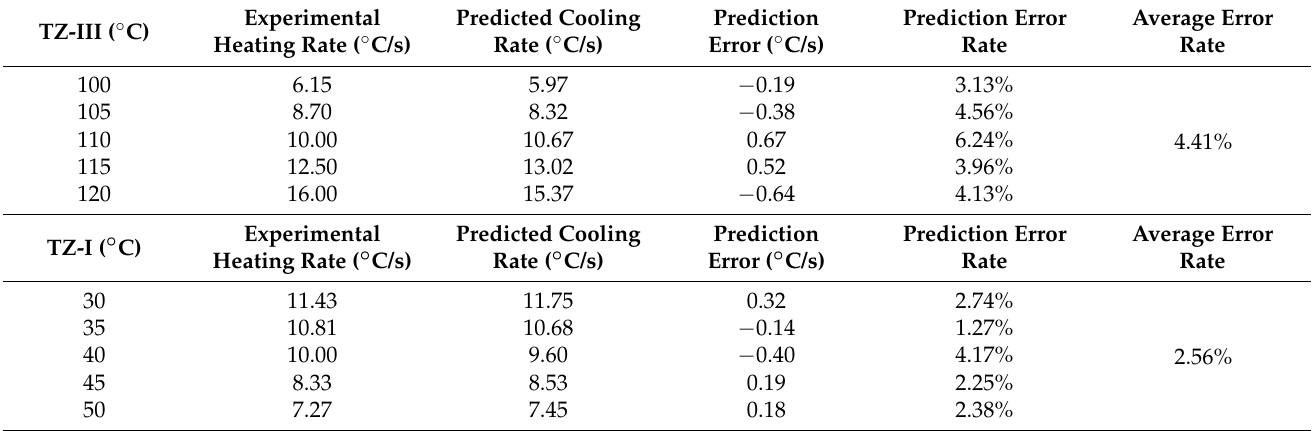
Table A4. Predicted ramp rates and errors at different temperatures in TZ-III and TZ-I.